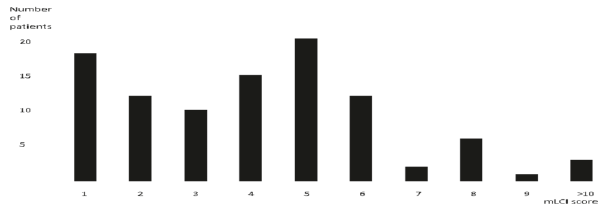
Figure 1: Distribution of mLCI score according to number of